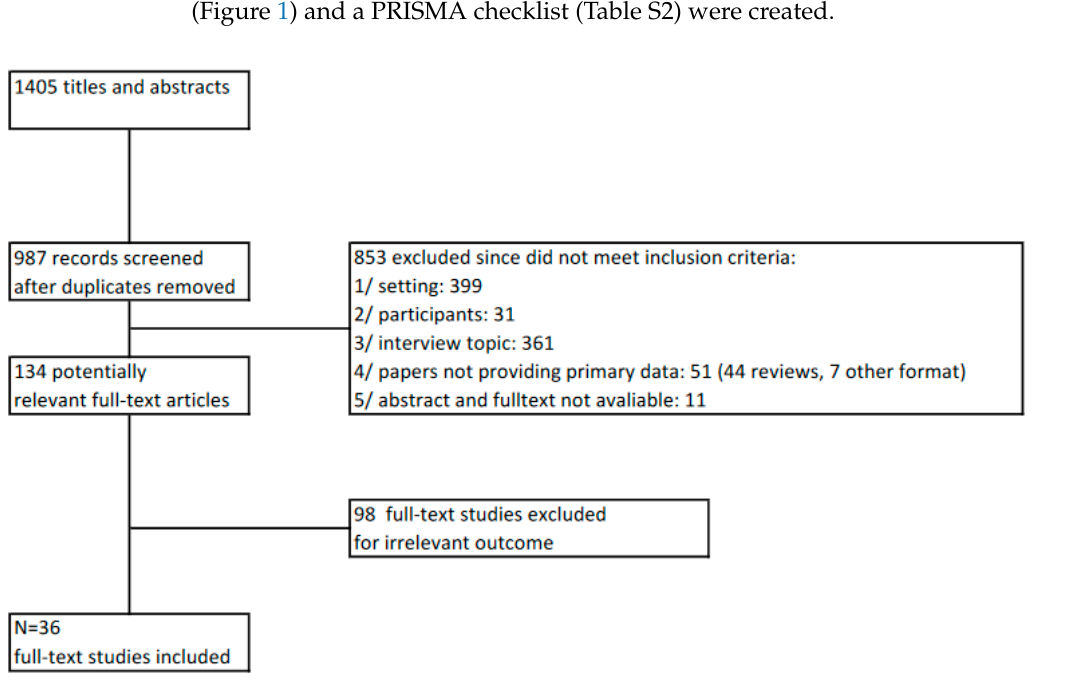
Table 1. Aspects of the communication process in delivering serious news. Group No.